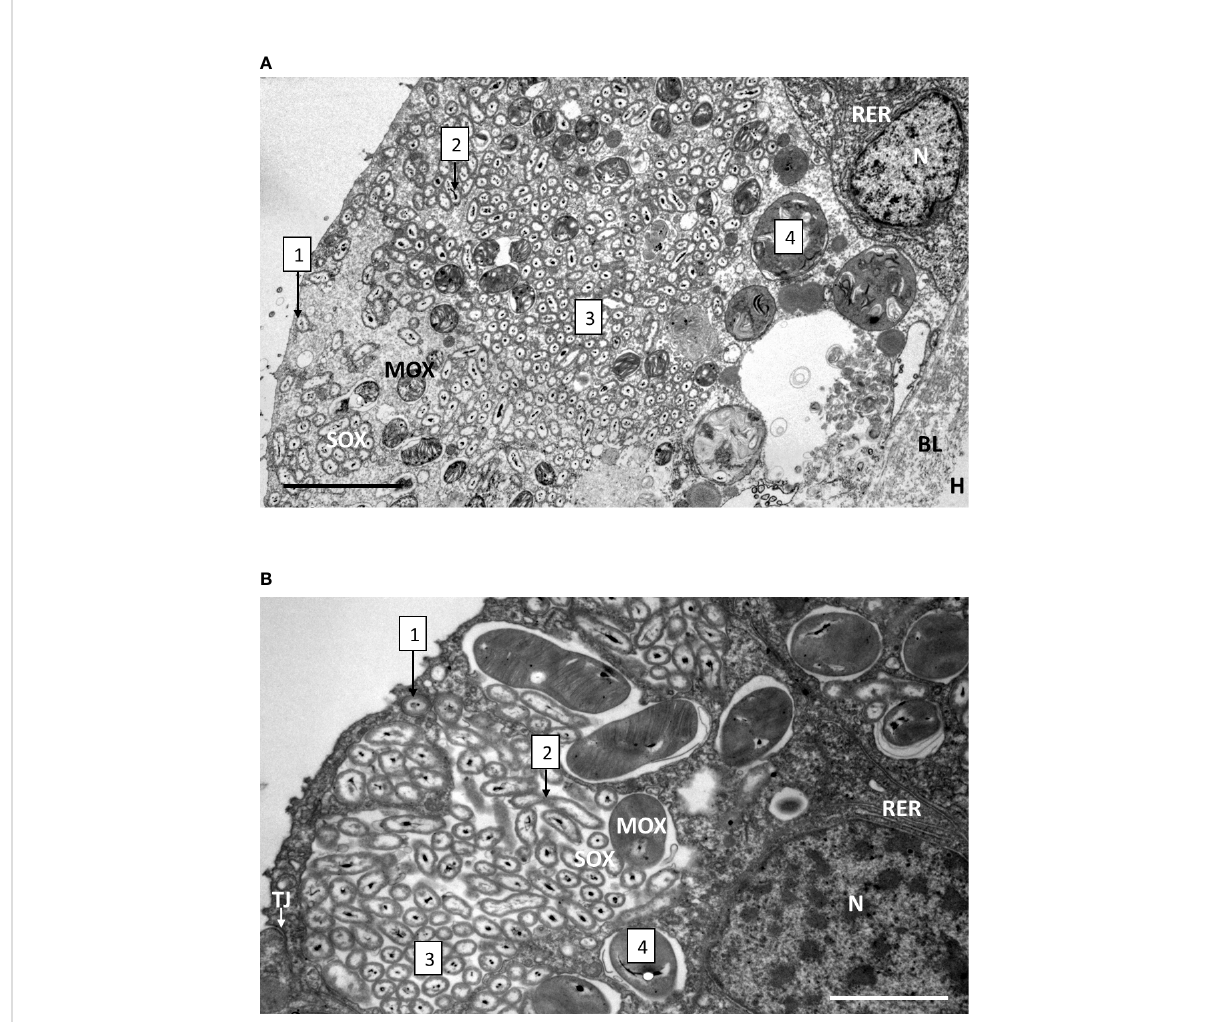
FIGURE 3 Gill epidermis immediately upon recovery, showing the bacteriocytes of B azoricus from Menez Gwen (A) and from Lucky Strike (B) . The boxed numbers on the microphotograph refer to the successive events, localized from the cellular apex (to the left on the pictures) to the basal lamina (to the right on the pictures), and detailed as follows: 1- Apical endocytosis of single symbionts (SOX or MOX) from the inhalant seawater fl ow. 2- Symbiont division. 3- Symbiont storage in vacuoles. 4- Symbiont digestion in the basal region of the bacteriocyte. Note that in B. azoricus from Menez Gwen (A) MOX and SOX appear segregated in separate vacuoles, while they share the same vacuoles in the mussels from Lucky Strike (B) . Abbreviations: BL basal lamina, H hemolymph, MOX methane-oxidizing symbiont, N nucleus, RER rough endoplasmic reticulum, SOX sul fi de-oxidizing symbiont, TJ tight junction. Scale bars represent 5 µm in (A) and 2 µm in (B)